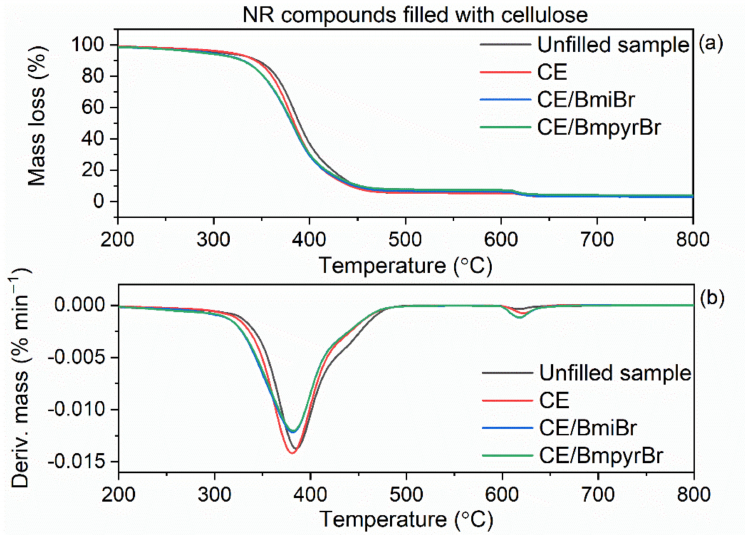
Figure 9. NR vulcanizates filled with CE: ( a ) TG curves; ( b ) DTG